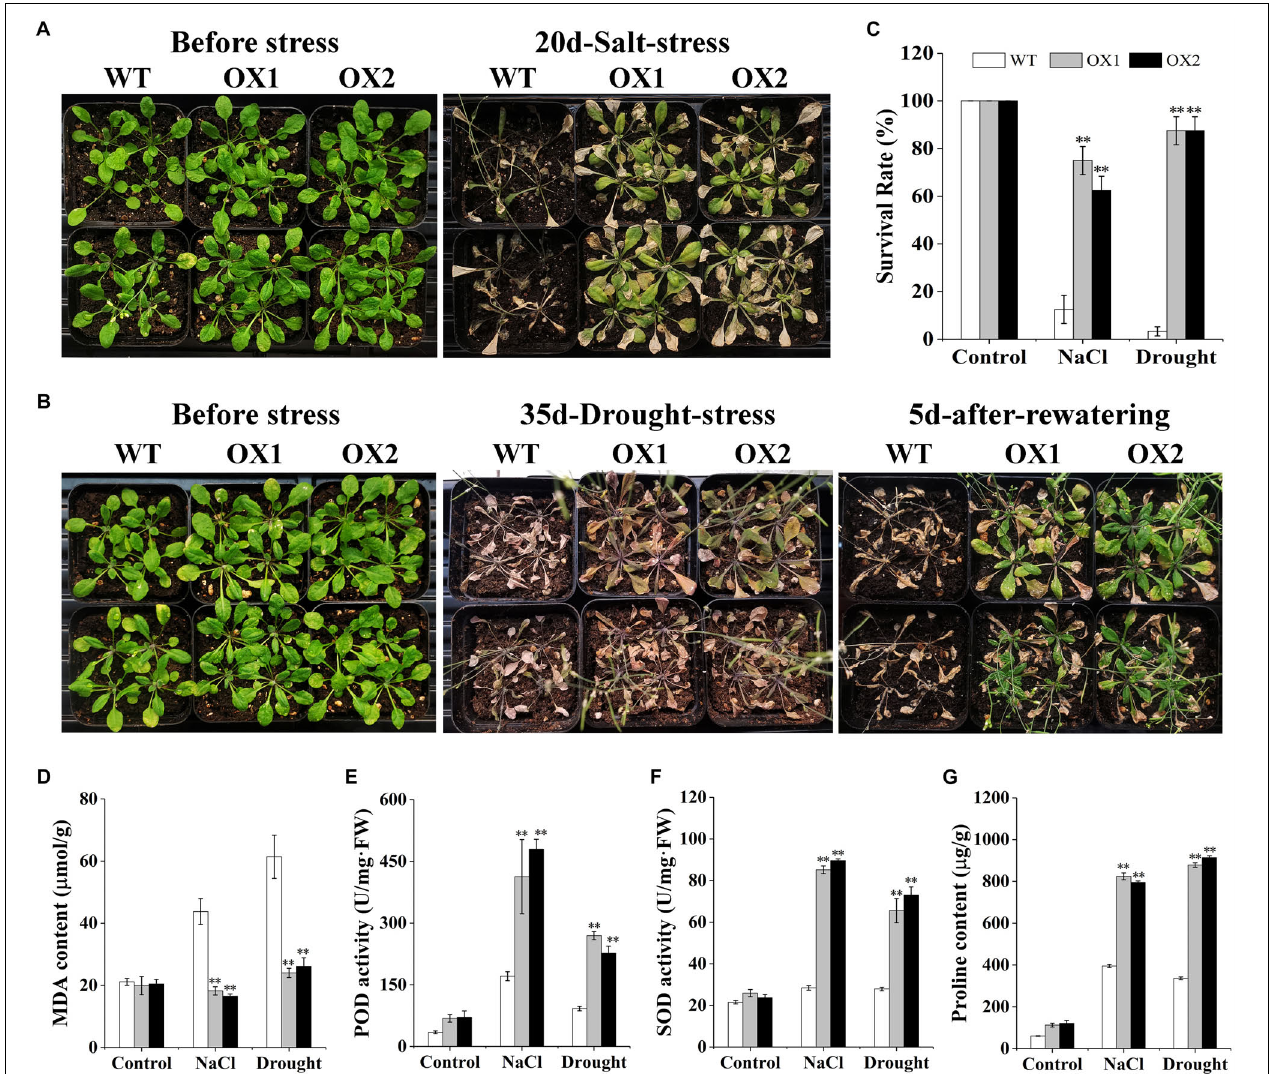
FIGURE 6 | Dehydration and salt stress resistance analysis of transgenic lines. (A,B) Performance of OoNAC72 -OX Arabidopsis plants under salt and drought stresses. Seedlings were grown without water for 35 days and re-watered for 5 days. (C) Survival rate after recovery from drought and salt stress. Each experiment comprises 20 plants. (D–G) Proline and MDA content, SOD and POD activities in WT and OoNAC72- OX lines after drought and salt stress. Each data point is the mean of three biological replicates. Error bars indicate SD, and asterisks indicate a significant difference ( ∗ P < 0.05; ∗∗ P < 0.01) compared with